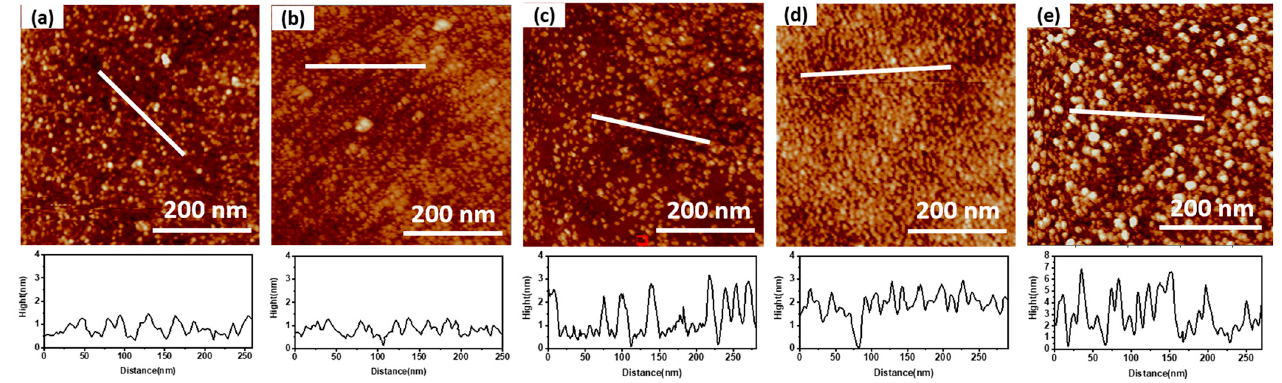
Figure 2. AFM characterization of surface morphology of ( a ) 30c-MoS 2 nanolayer, ( b ) 45c-MoS 2 nanolayer, ( c ) 60c-MoS 2 nanolayer, ( d ) 75c-MoS 2 nanolayer, and ( e ) 90s-MoS 2 nanolayer.